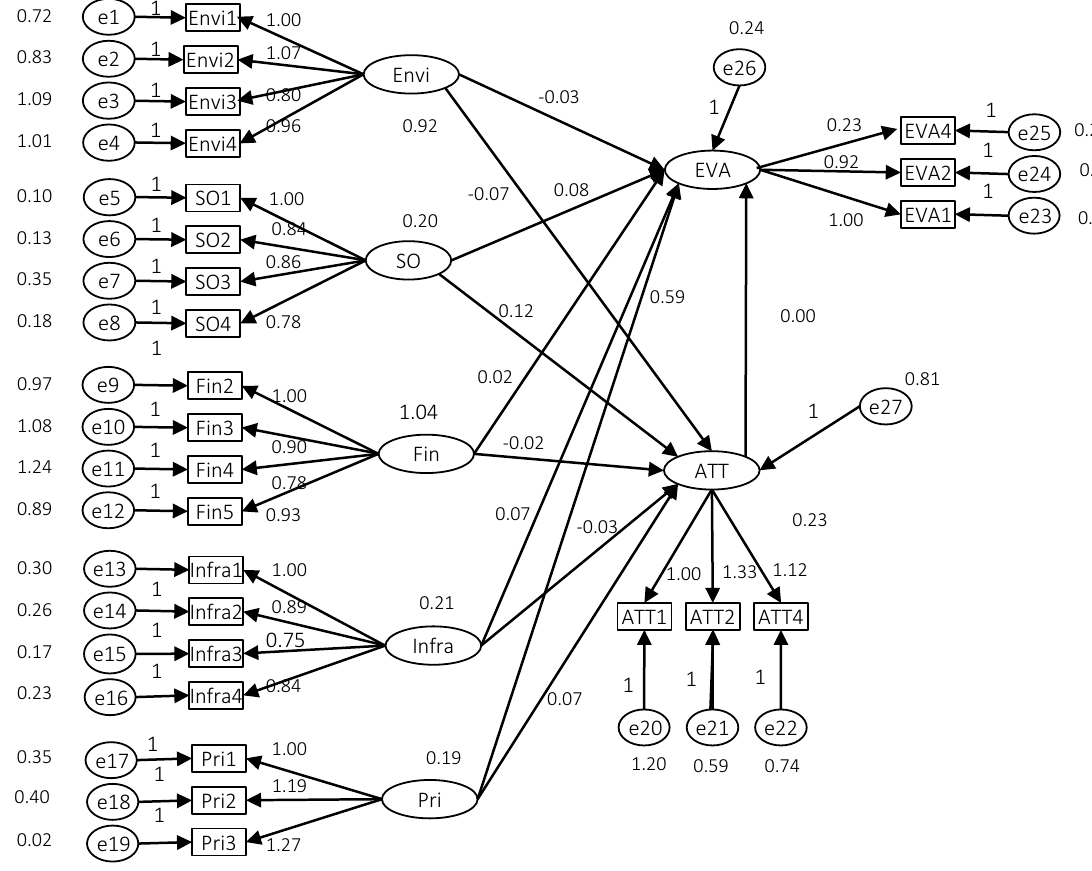
Figure 3. Structural